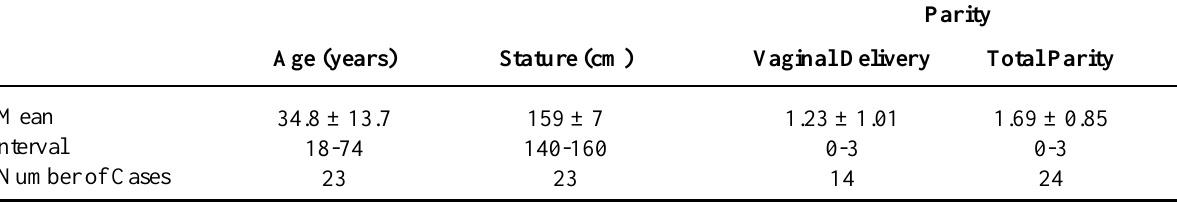
Table 1 – Characteristics of the sample in relation to age, corporeal weight, stature and parity (mean ± standard devia- tion).